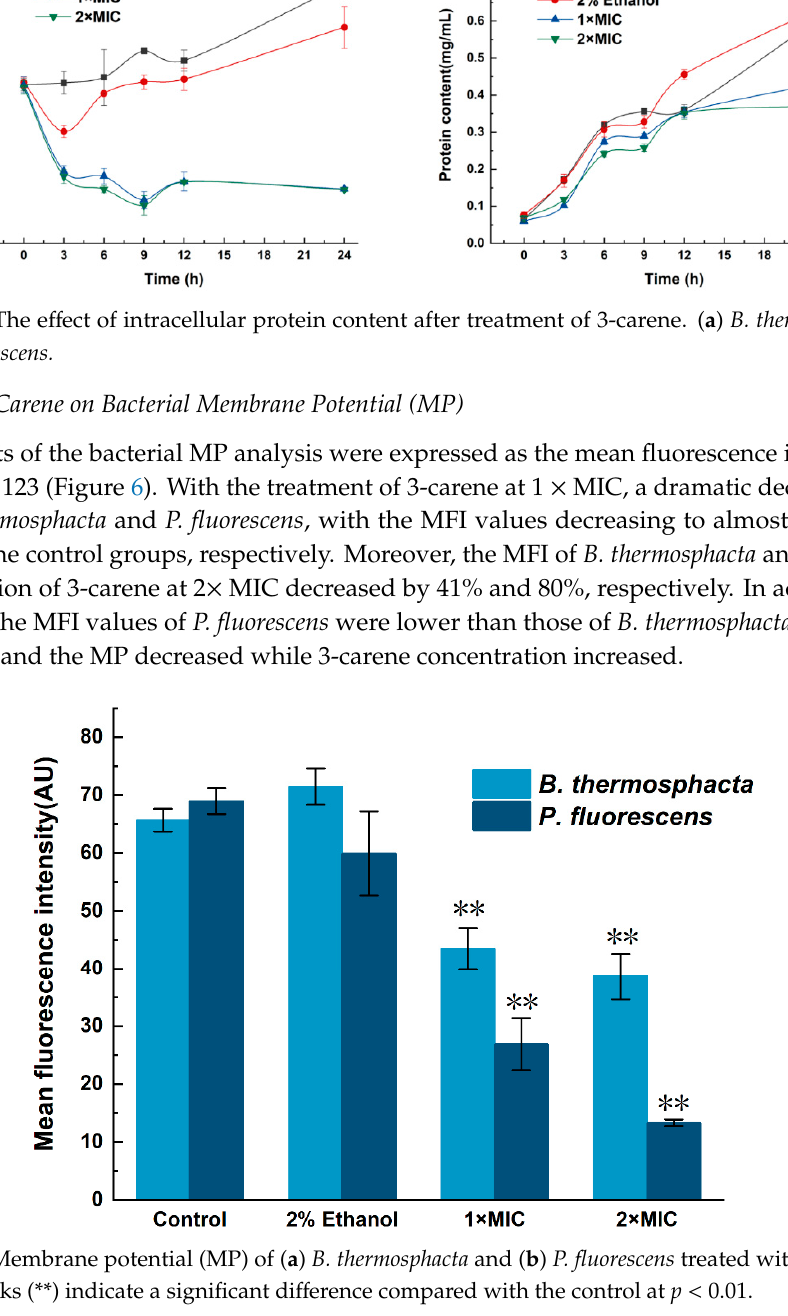
Figure 6. Membrane potential (MP) of ( a ) B. thermosphacta and ( b ) P. fluorescens treated with 3-carene. The asterisks (**) indicate a significant difference compared with the control at p <